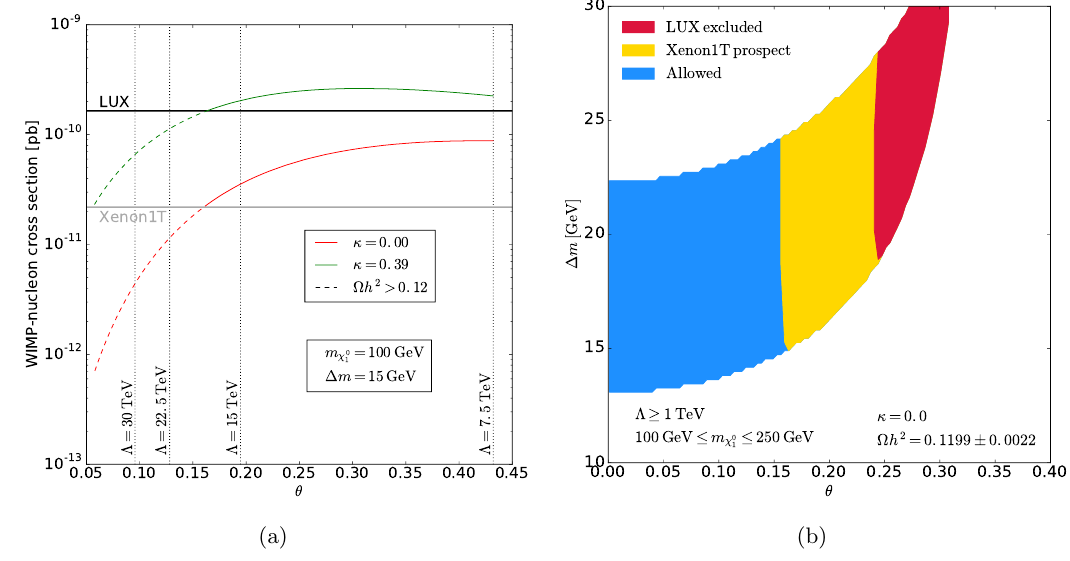
Figure 3 . Left panel: WIMP-nucleon cross section in the triplet model for m mass splitting of (cid:1) m = 15 GeV. Here (cid:18) is the triplet-singlet mixing angle. Direct detection